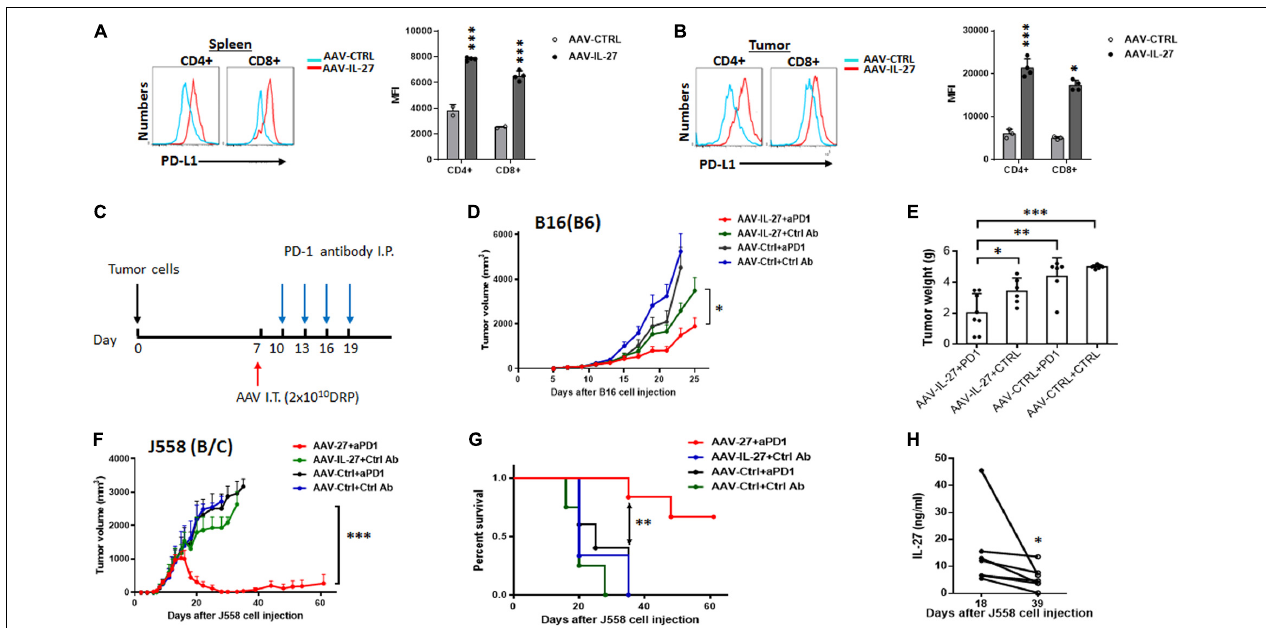
FIGURE 5 | Intra-tumoral injection of AAV–IL-27 induces PD-L1 expression in T cells and enhances tumor sensitivity to anti-PD-1 therapy. (A,B) Flow cytometry analysis of CD4 + and CD8 + T cells in spleen (A) and tumors (B) from C57BL6 mice that were treated intra-tumorally with AAV-IL-27 or AAV-ctrl virus. Average mean fluorescence intensity (MFI) of PD-L1 expression in T cells from each group of mice was also shown. (C) Schematic diagram of intra-tumoral AAV-IL-27 and anti-PD-1 combination therapy. Mice are injected with tumor cells s.c. Seven days later, mice with established tumors are treated with AAV–IL-27 or AAV-ctrl virus intra-tumorally. Starting on day 10, mice are also treated with 250 µ g/mouse of anti–PD-1 (RMP1-14) or an isotype-matched control antibody (2A3) i.p. at 3-day intervals for up to 4 times. (D,E) Synergy of anti-PD-1 and intra-tumoral AAV-IL-27 in inhibiting the growth of B16.F10 melanoma. AAV–IL-27 or AAV-ctrl virus intra-tumoral treatment were at a dose of 2 × 10 11 DRP/mouse. Tumor volume changes (D) and mice tumor weight (E) were recorded. (F,G) Synergy of anti-PD-1 and intra-tumoral AAV-IL-27 in inhibiting the growth of J558 tumors. AAV-IL-27 or AAV-ctrl virus intra-tumoral treatments were at a dose of 5 × 10 10 DRP/mouse. Tumor volume changes (F) and mice survival (G) were recorded. Data were expressed as Mean ± SD of at least five mice in each group. Data shown represent 2–3 experiments with similar results. Ns: no significant difference. * P < 0.05, ** P < 0.01, *** P < 0.001 by One-way ANOVA or Log-rank test. (H) IL-27 concentration in peripheral blood from BALB/c mice receiving intra-tumoral AAV-IL-27 and anti-PD-1 combination therapy were